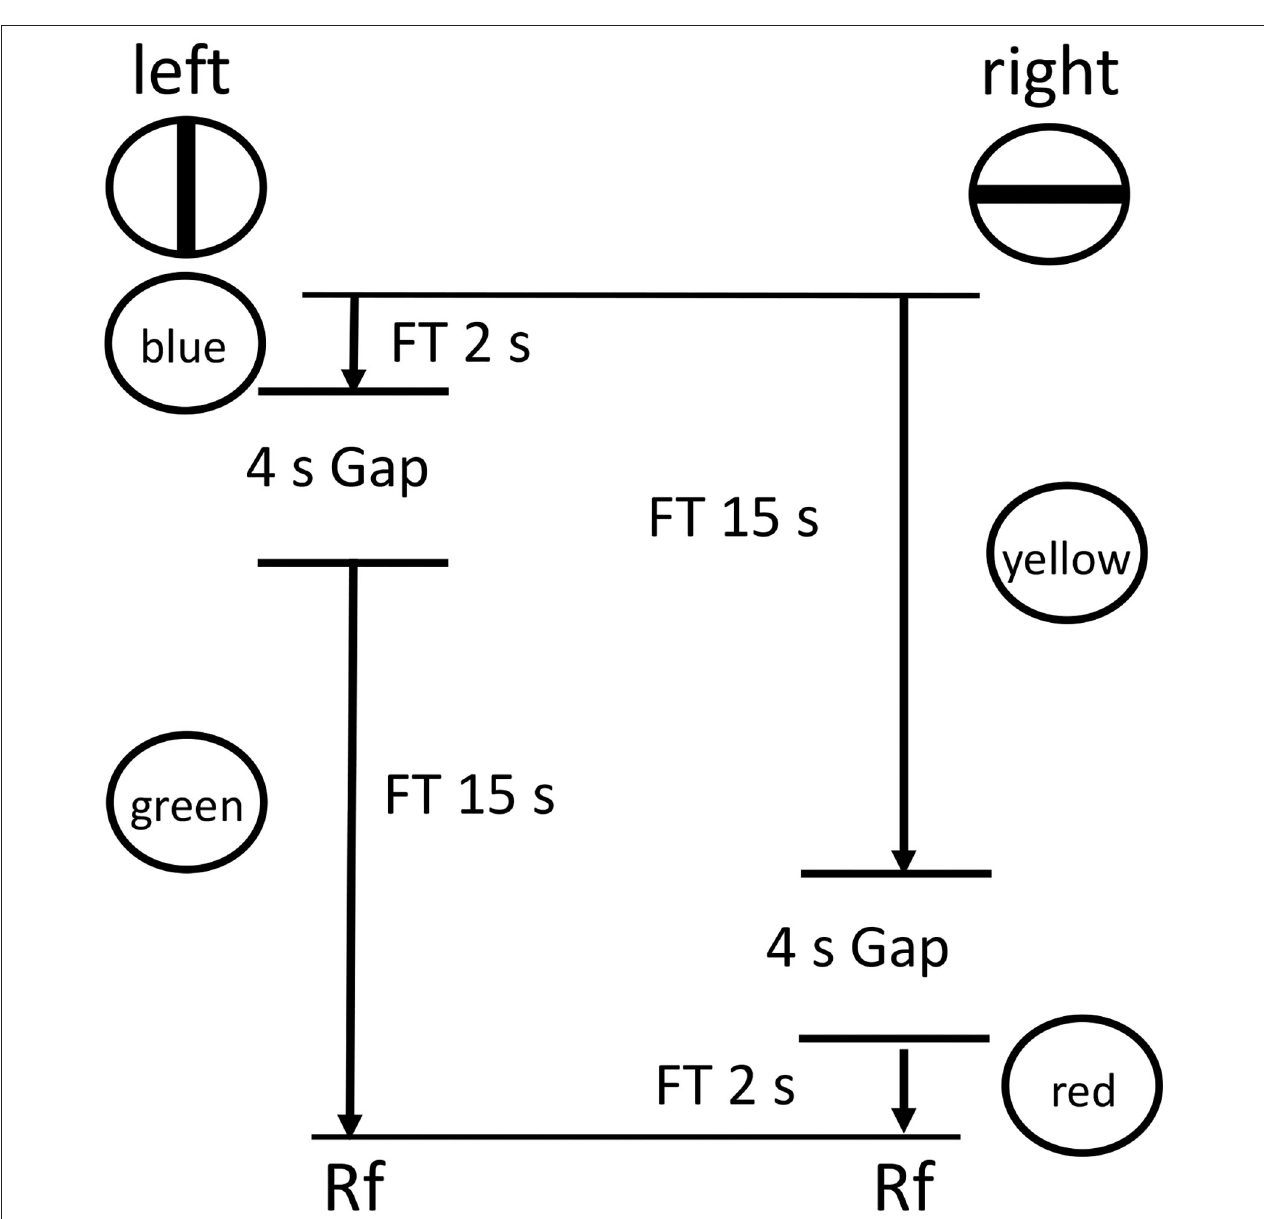
FIGURE 8 | Design of the Zentall et al. (2020, Experiment 1) experiment. Pigeons were given a choice between two reinforced chains, short (FI 2s) followed by long (FI 15s) or long (FI 15s) followed by short (FI 2s), with a 5s dark period (a gap) between the two links of each chain.